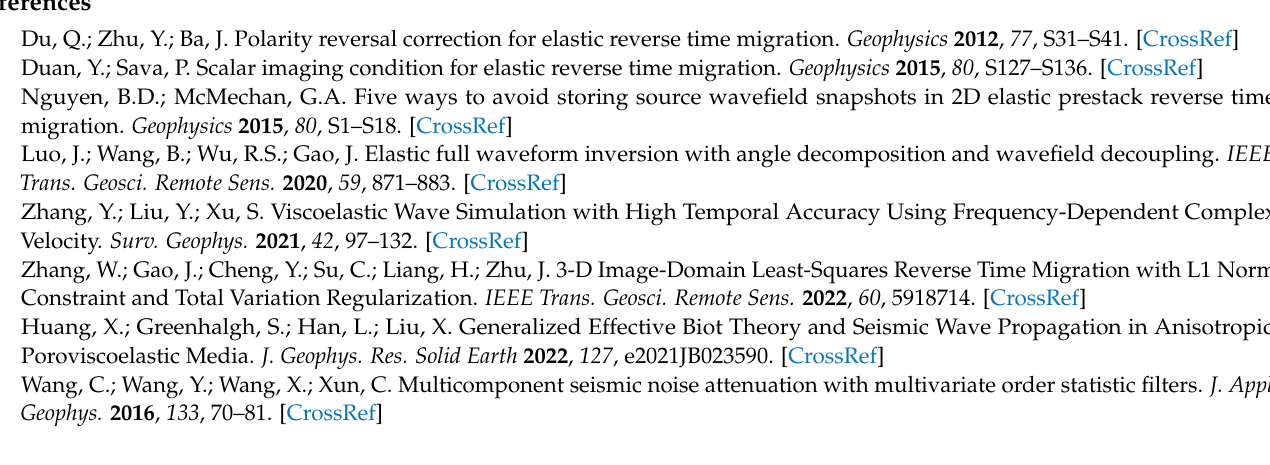
Figure 13. Comparison of wavenumber spectra that are selected from Figure 12 at the depth of 3 km, ( a ) PP-component, ( b ) PS − component.